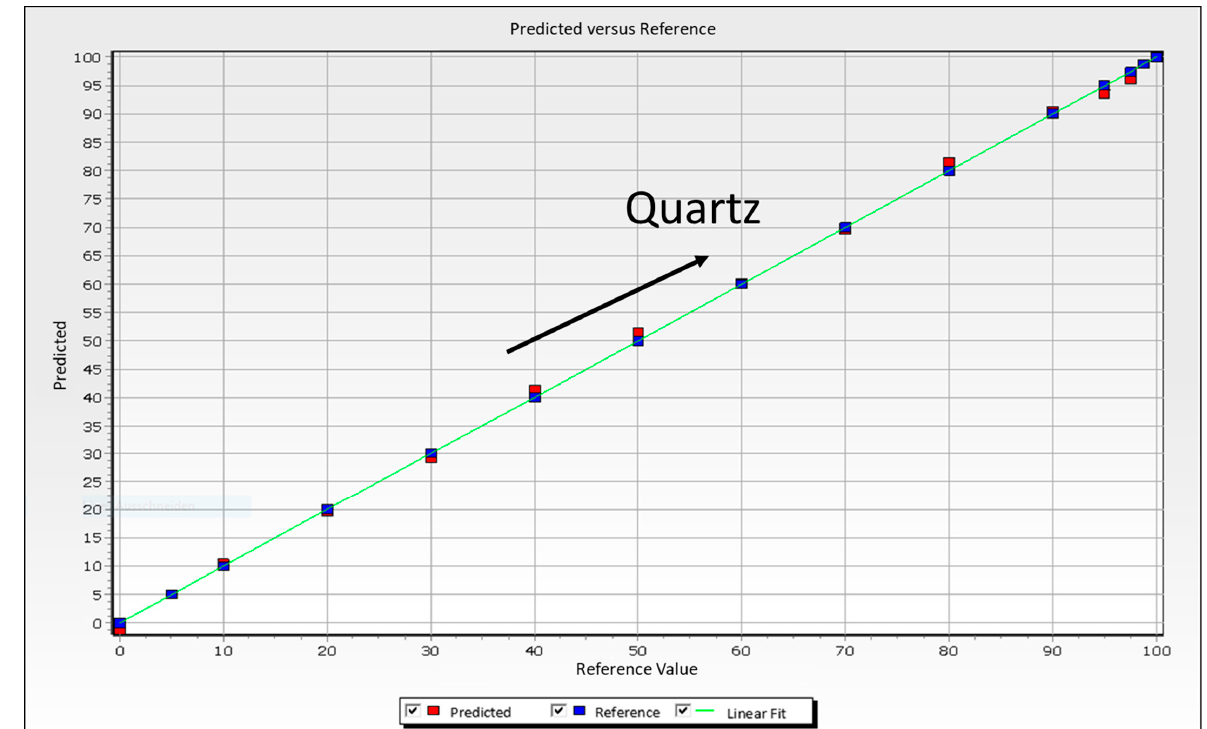
Figure 4. Determination limit of petalite in quartz matrix using main peaks of petalite. ( a ) Part of XRD pattern petalite and mixture of 95% quartz/5% Petalite; ( b ) Main peak of petalite in quartz matrices of different contents